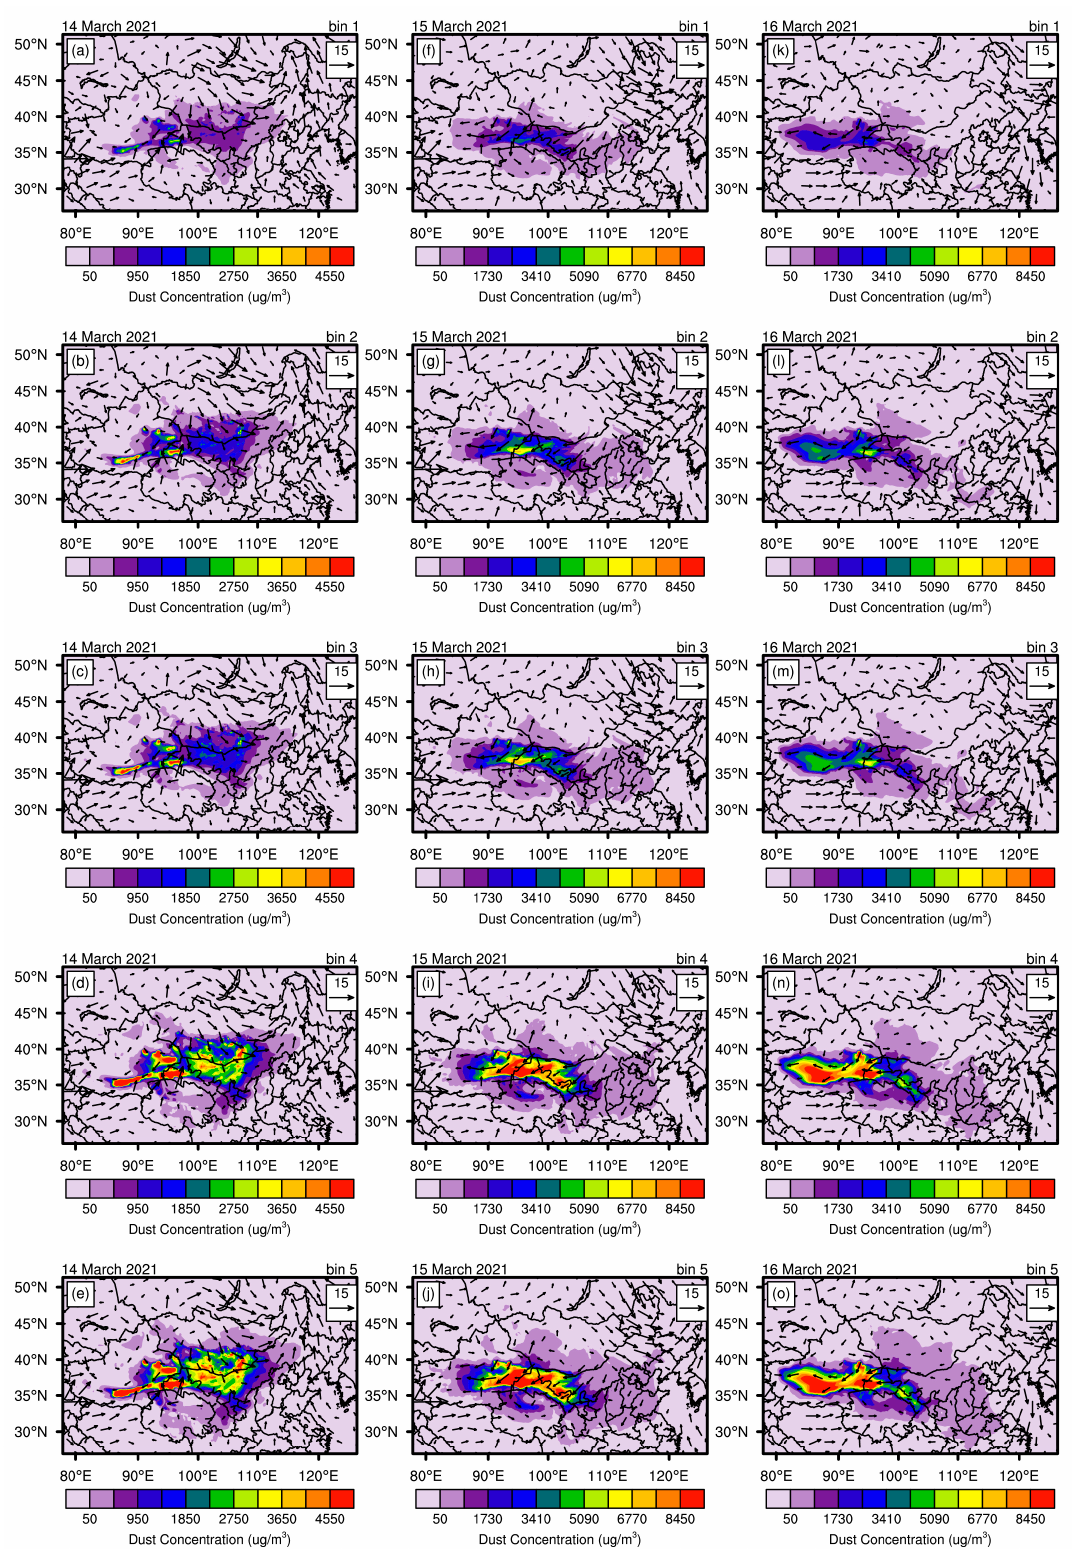
Figure 7. Spatial distributions of the daily mean surface dust mass concentrations (units: µ g/m 3 ) in bin 1 (the radius of 0.1–1.0 µ m, a , f , k ), bin 2 (the radius of 1.0–1.8 µ m, b , g , l ), bin 3 (the radius of 1.8–3.0 µ m, c , h , m ), bin 4 (the radius of 3.0–6.0 µ m, d , i , n ), and bin 5 (the radius of 6.0–10.0 µ m, e , j , o ), overlaid surface wind fields (units: m/s) on 14–16 March 2021 simulated by WRF-Chem model.